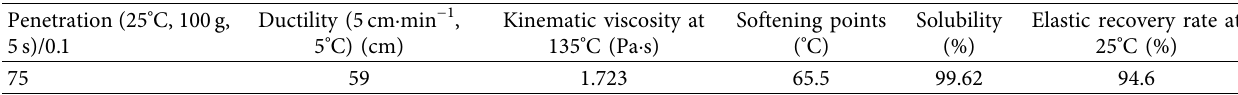
Table 2: Technique performance of SBS-modified asphalt.